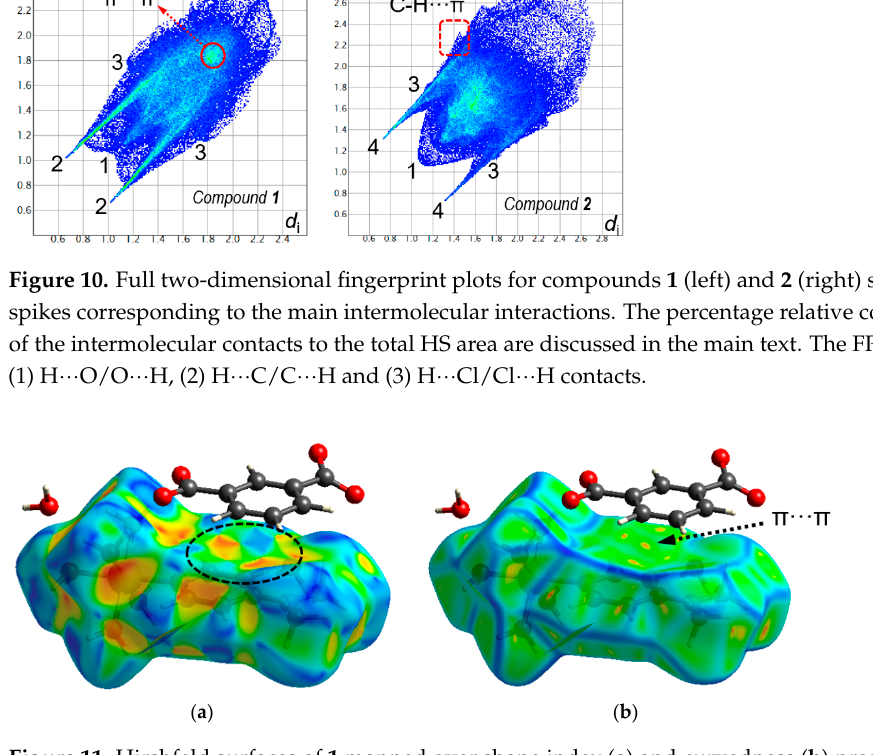
Figure 11. Hirshfeld surfaces of 1 mapped over shape index ( a ) and curvedness ( b ) properties. Compound 2 : The red regions labeled 1 and 3 in the d norm surface (Figure 9) are at- tributed to O2W-H2W···Cl1 and O1W-H1W···Cl1 involving the H-atoms of the coordi- nated water molecules and the chlorine anion as the acceptor. The two large red spots labeled 2 on the HS are mainly associated to N7-H7···Cl1 hydrogen bonds involving the N-H moiety of the pyrazole ring as the donor. The red regions labeled 5 and 6 in the d norm map are attributed to C10-H10A···Cl1 and C51-H51A···Cl1 hydrogen bonds, involving the H-atoms of the methyl group and the Cl1 anion as the acceptor. These H···Cl/Cl···H contacts are visible as sharp spikes (labeled 4) in the FP plots (Figure 10) at around ( d e + d i ) ≈ 2.00 Å, with a contribution of 14.3% to the Hirshfeld surface area. These contacts are visible in the d norm surface as small red spots labeled 4 and comprise 76% of the total HS area.